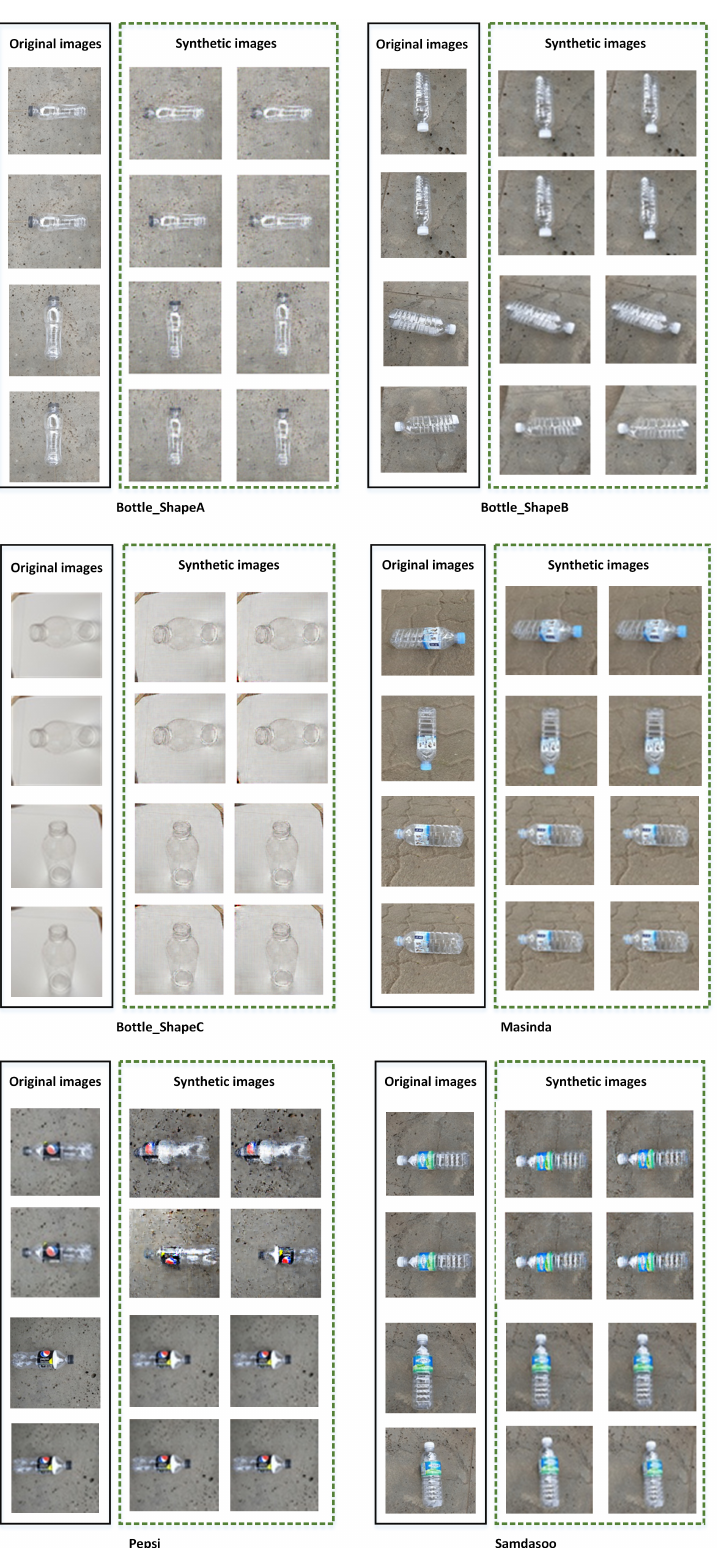
Figure 8. Original plastic bottle images and synthetic plastic bottle images generated by modified